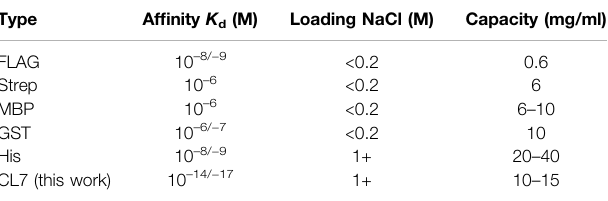
TABLE 1 | Comparison of the commonly used chromatographic